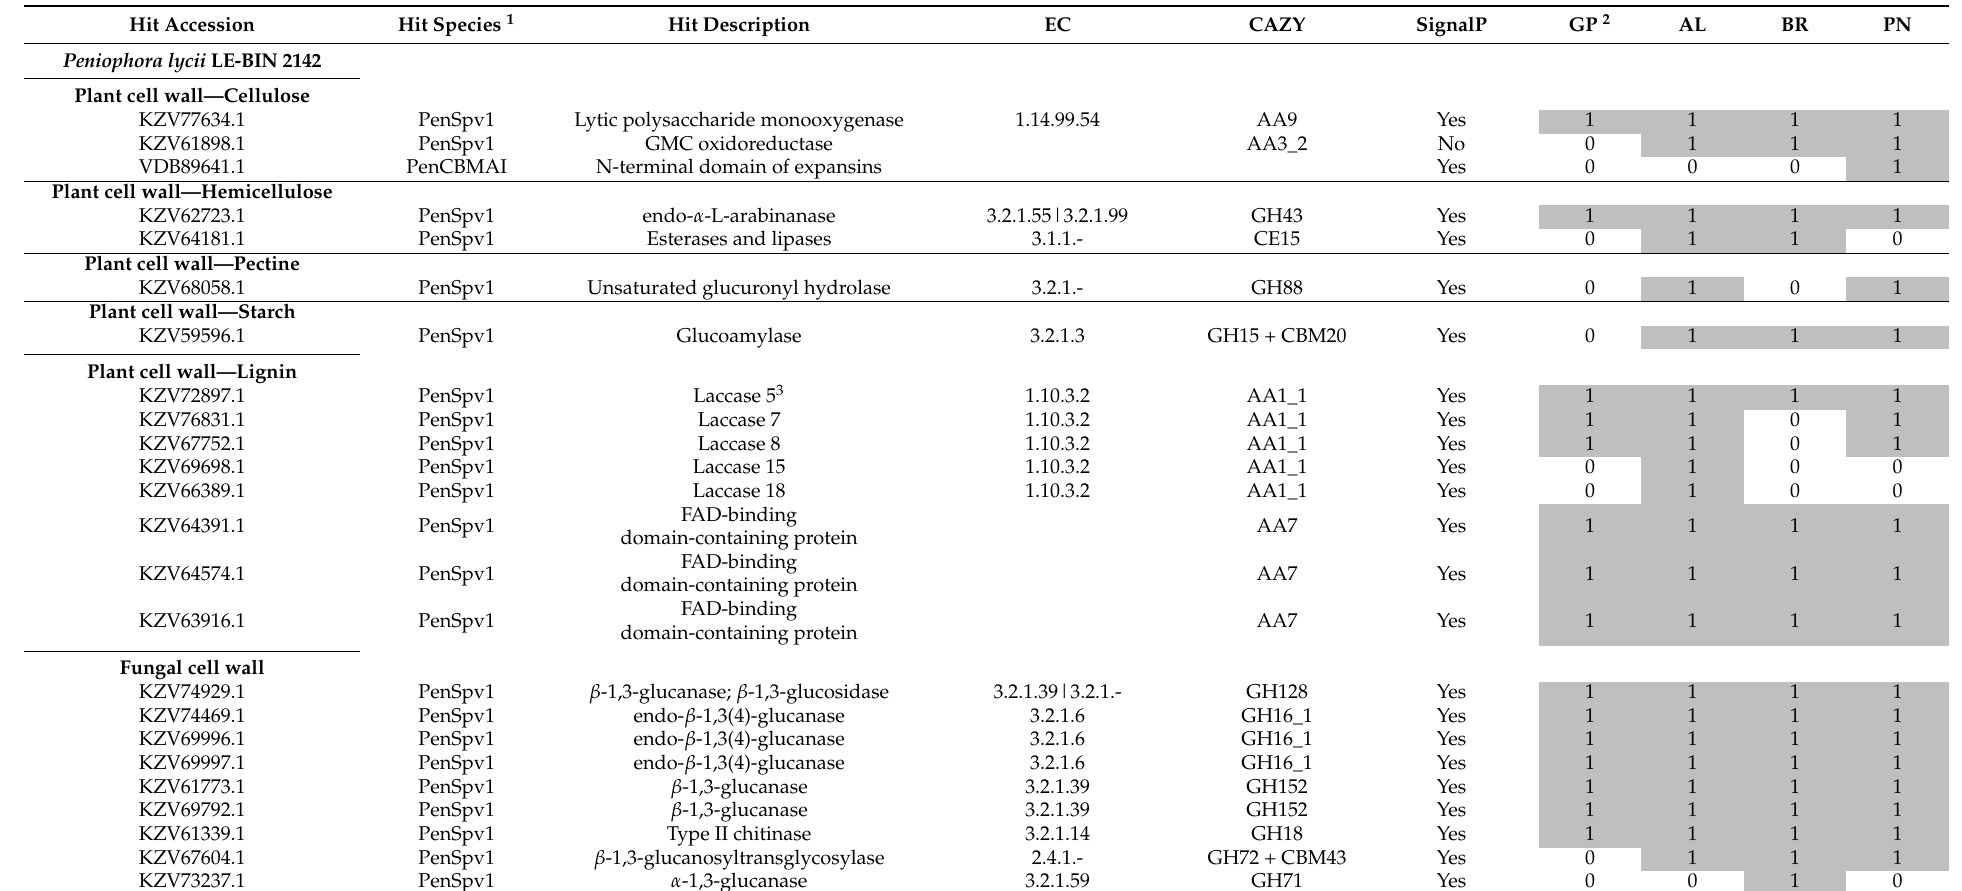
Table 1. Functional description and secretion conditions for the proteins detected in the exoproteomes of P. lycii LE-BIN 2142 and T. hirsuta LE-BIN 072 during their semi-solid cultivation on media containing various types of